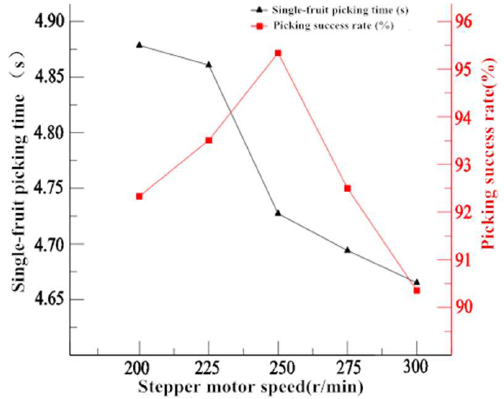
Figure 13. Effect of different stepper motor speeds on picking performance.